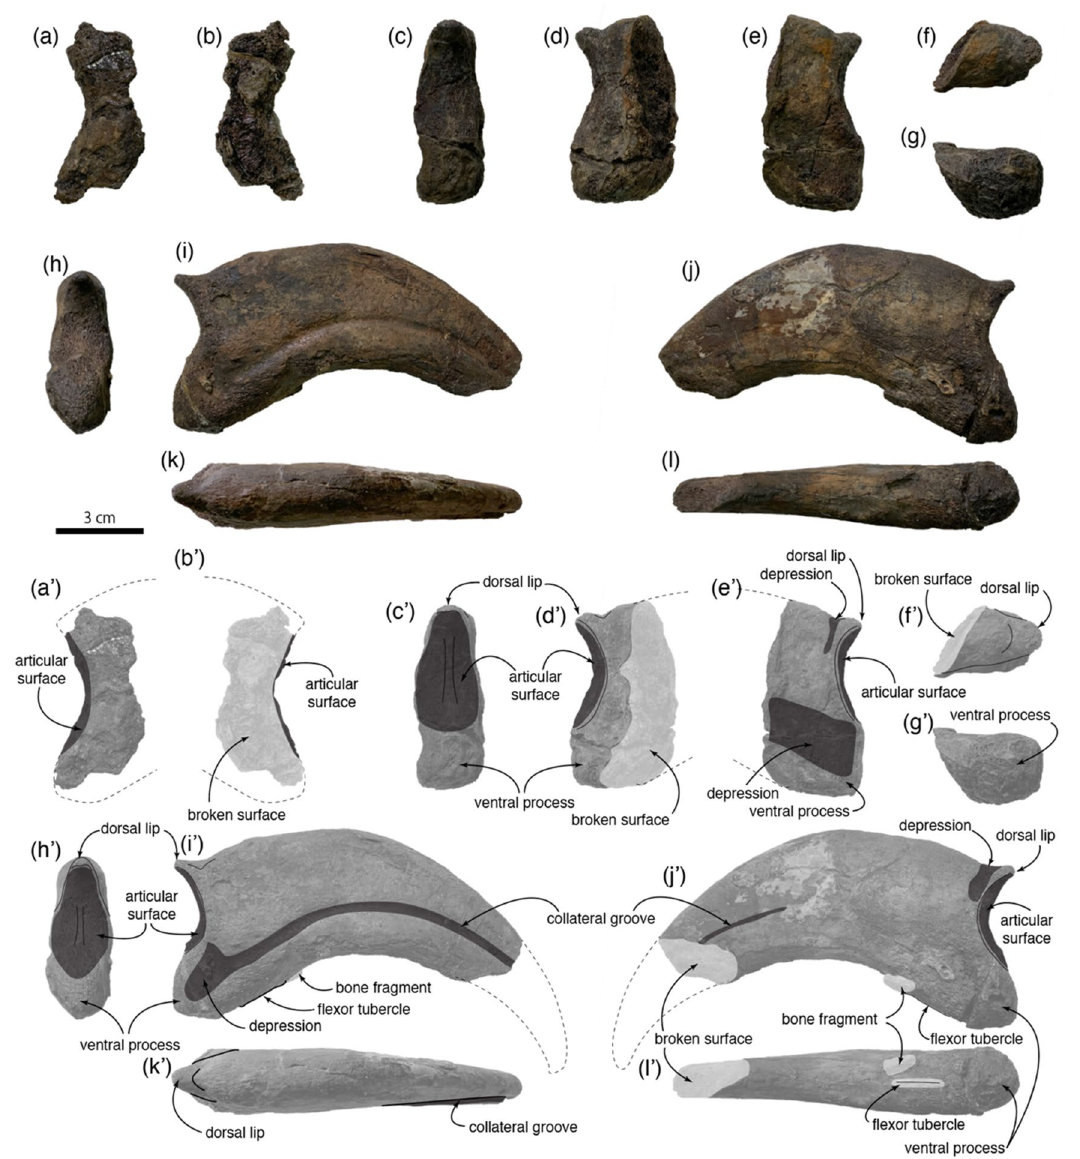
Figure 4. Right manual unguals of Paralitherizinosauruss japonicus gen. et sp. nov. Ungual of digit I in lateral ( a ) and medial ( b ) view. Ungual of digit II in proximal ( c ), lateral ( d ), medial ( e ), dorsal ( f ), and ventral ( g ) views. Ungual of digit III in proximal ( h ), lateral ( i ), medial ( j ), dorsal ( k ), and ventral ( l ) views. ( a ′ ) to ( l ′ ) are corresponding images in black and white with labels. This figure was created by using Adobe Photoshop 21.2.0 and Adobe Illustrator 24.2.1 (https:// www. adobe.